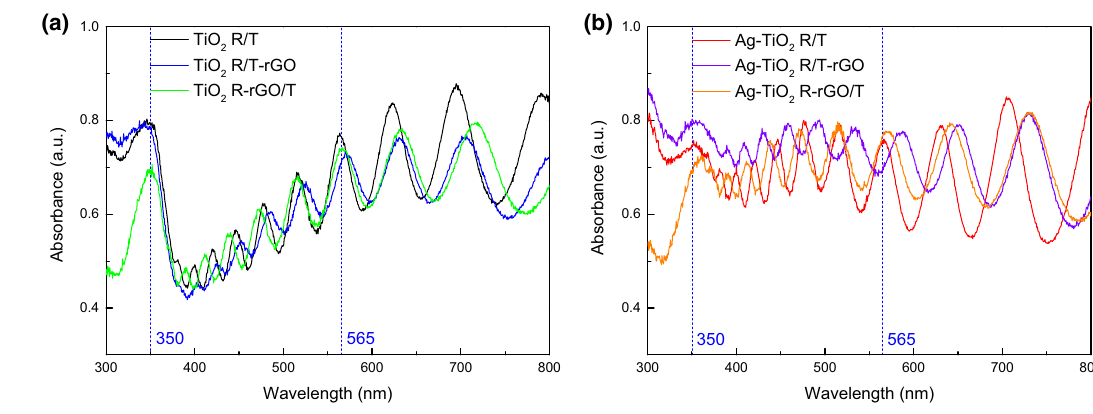
Fig. 5 UV-Vis absorption spectra of a TiO 2 R/T, TiO 2 R/T-rGO, TiO 2 R-rGO/T and b Ag-TiO 2 R/T, Ag-TiO 2 R/T-rGO, Ag-TiO 2